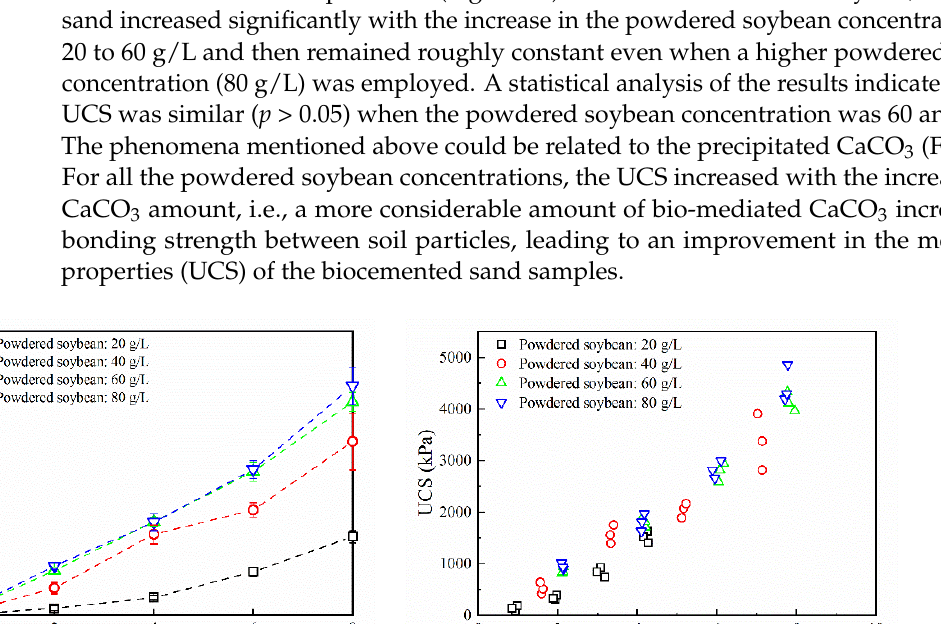
( b ) Figure 6. Effect of powdered soybean concentration and treatment cycle on ( a ) chemical conversion efficiency and ( b ) total CaCO 3 content. 3.3. Effect of Powdered Soybean Concentration (Urease Activity) on the Properties of